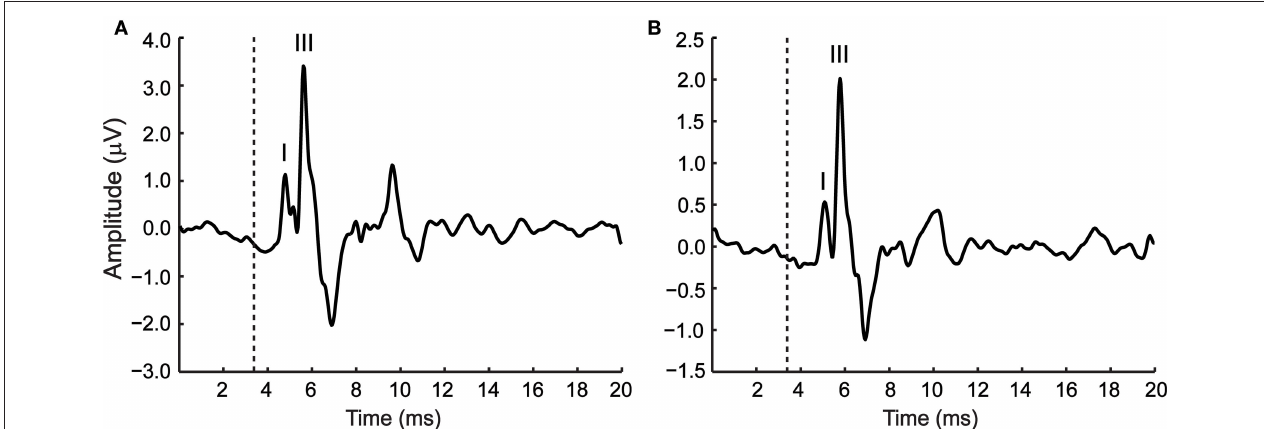
respectively. The dotted line indicates stimulus onset at the ear. The time of the recording window (20 ms) is indicated along the x axis and the amplitude of the ABR along the y axis.